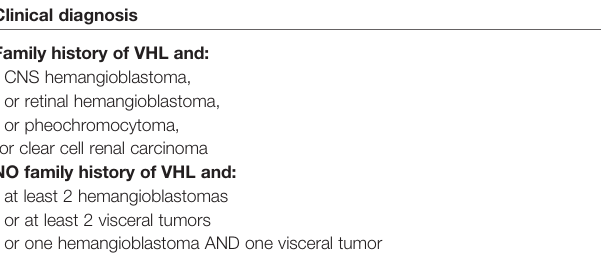
TABLE 2 | von Hippel-Lindau disease diagnostic criteria. Adapted from (10). Clinical